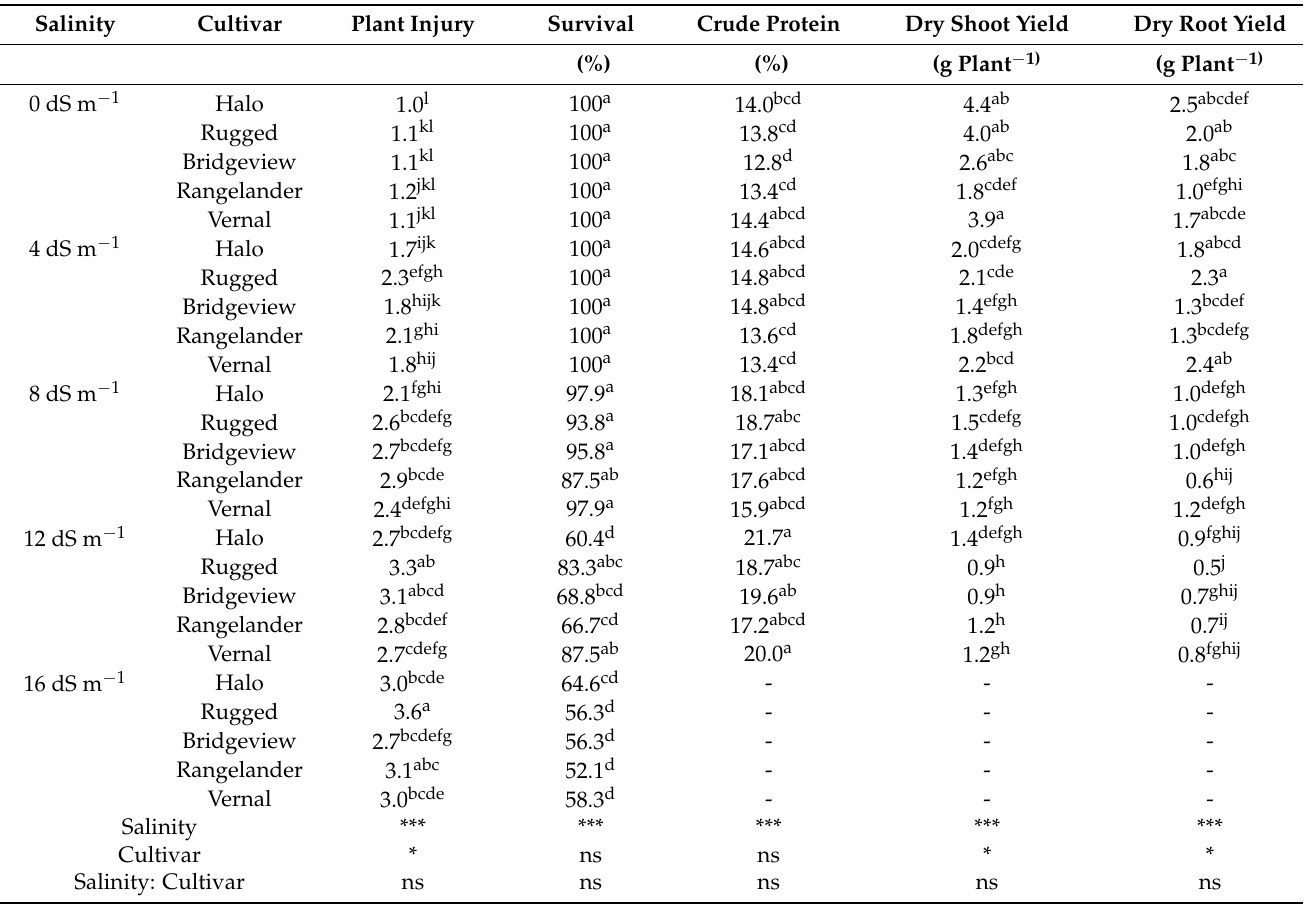
Table 1. Mean value (2-yr) of plant injury, survival, crude protein, dry biomass yield of